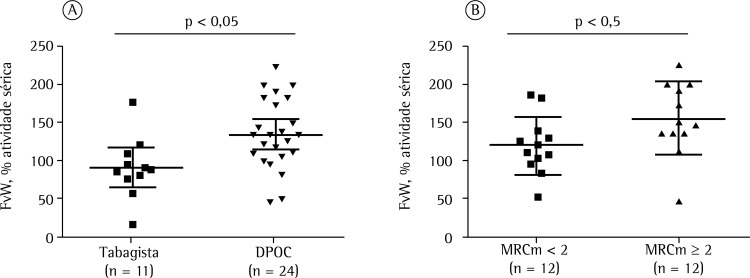
Níveis séricos do percentual de atividade do fator de Von Willebrand
(FvW). Em A, comparação entre os grupos tabagista e DPOC. Em B, comparação
entre os subgrupos DPOC sintomáticos e DPOC assintomáticos/pouco
sintomáticos de acordo com os escores da escala Medical Research Council
modificada (MRCm).